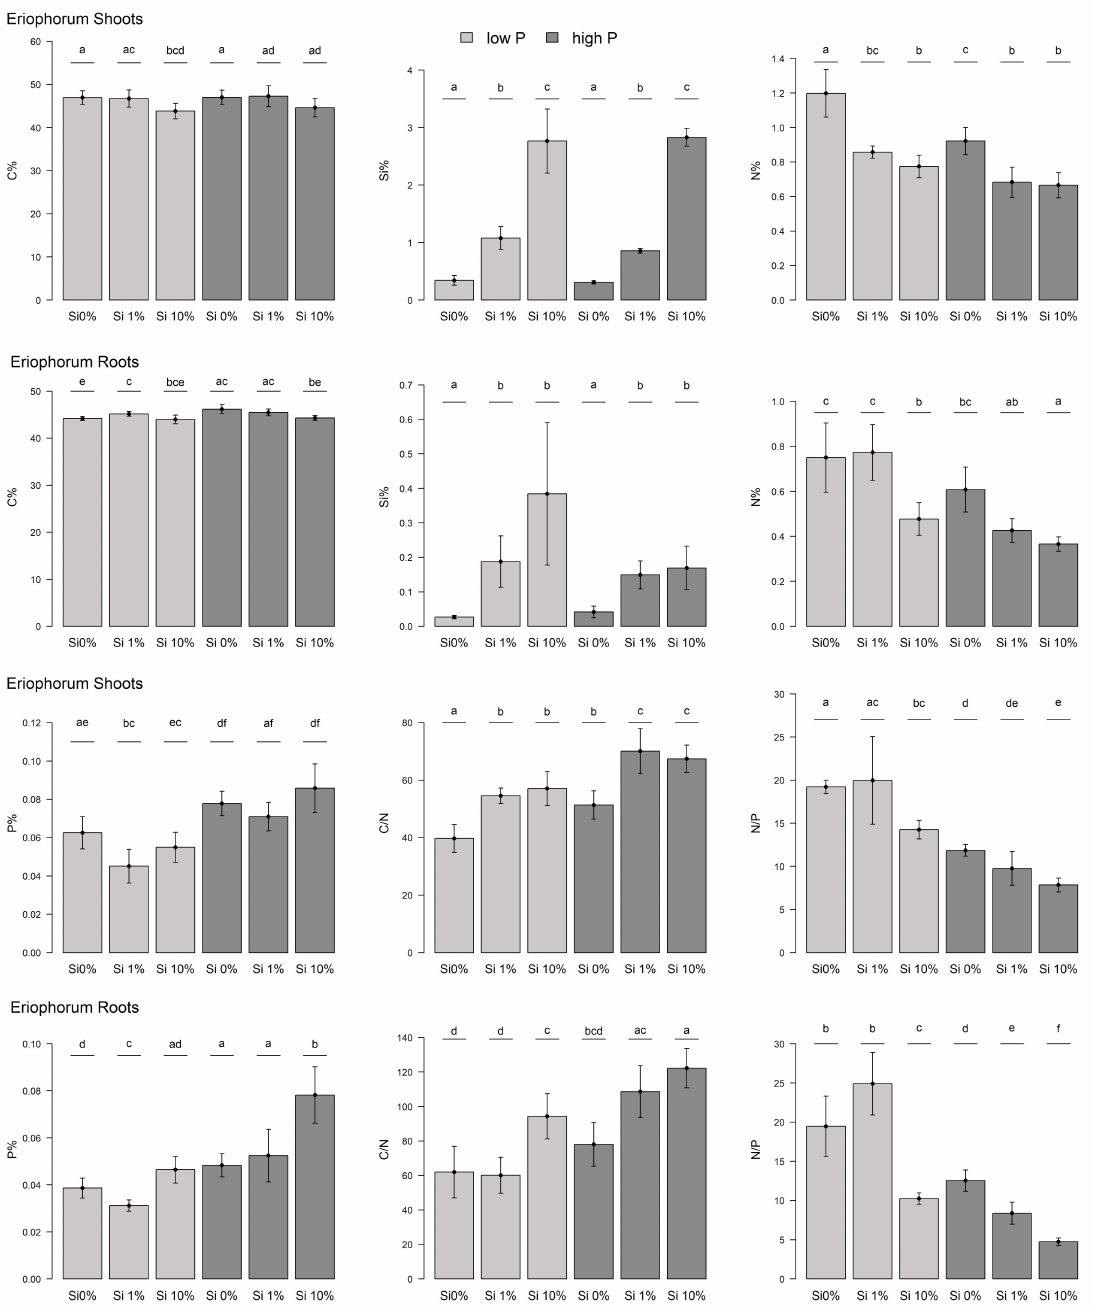
Figure 1. Element mass fractions and stoichiometry of Eriophorum aboveground and belowground biomass. Mass fractions of C, Si, N as well as P and the C/N and N/P ratios are displayed. Low-P fertilized plants: light gray, high-P fertilized plants: dark gray. Different letters give significant differences between the treatments ( α =